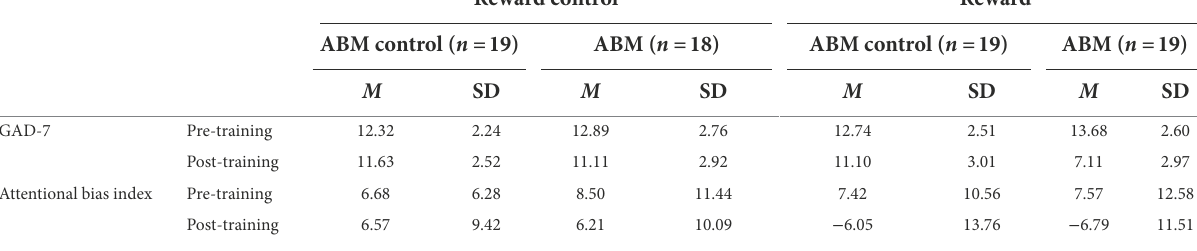
TABLE 2 Mean and SD of GAD-7 and attentional bias index by group during pre-training and post-training. Reward control Reward